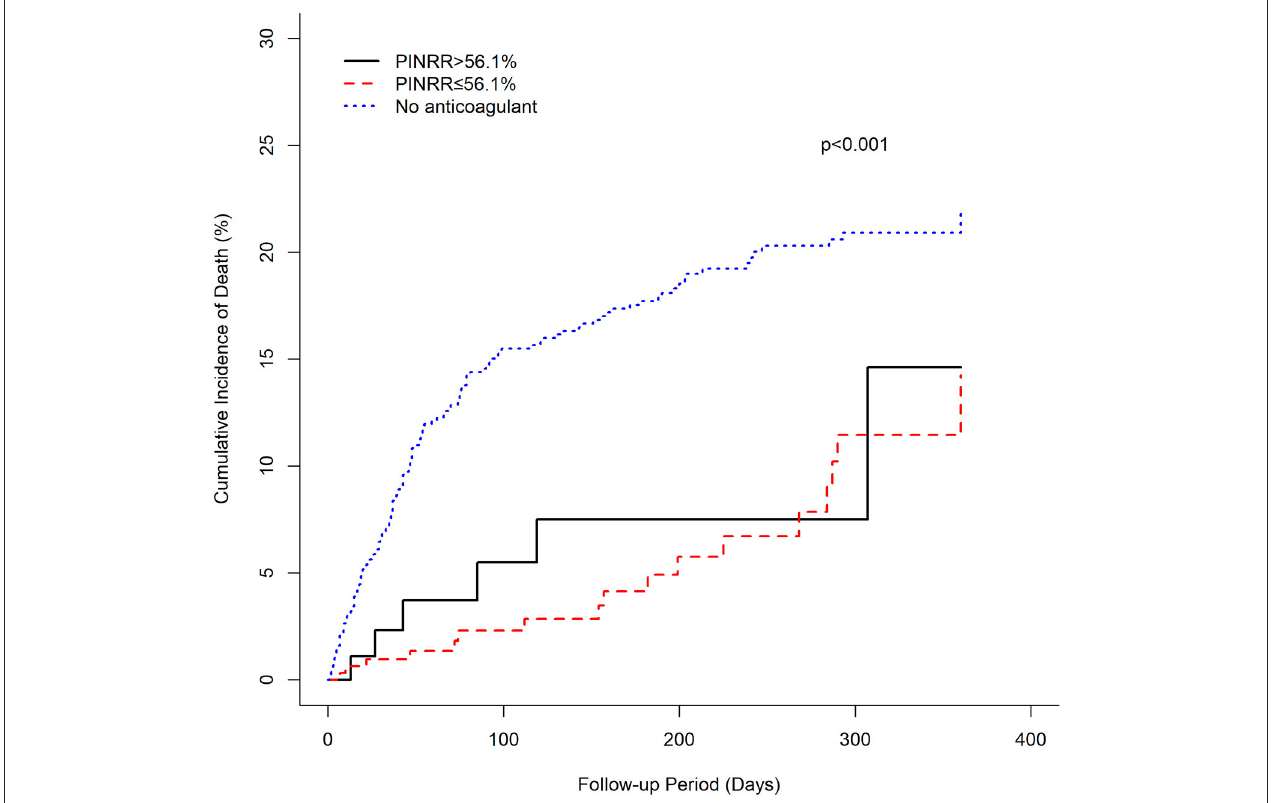
FIGURE 2 | Cumulative mortality of warfarin groups and the anticoagulant-untreated group (PINRR).